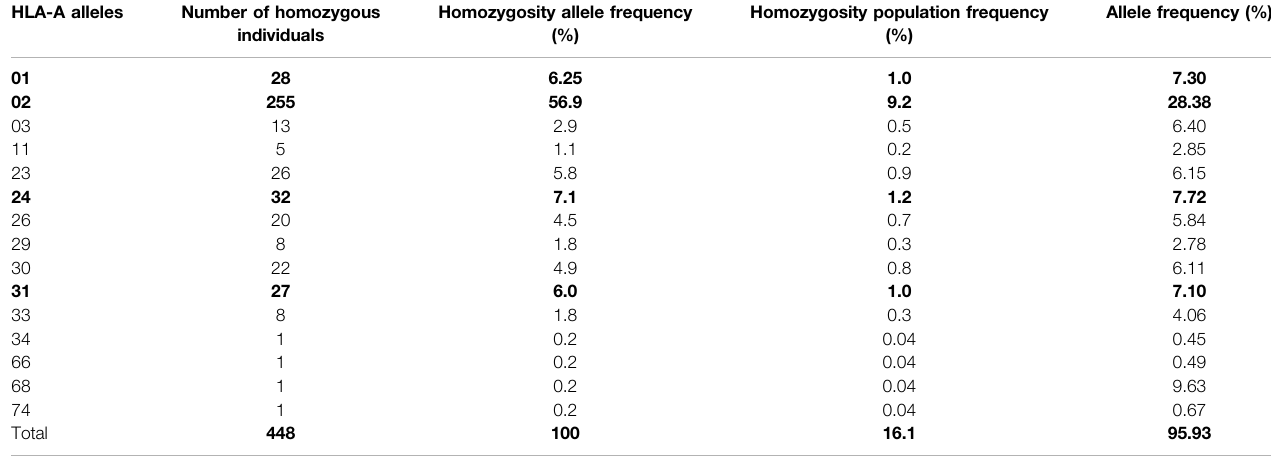
Bold values indicate the highest frequencies.